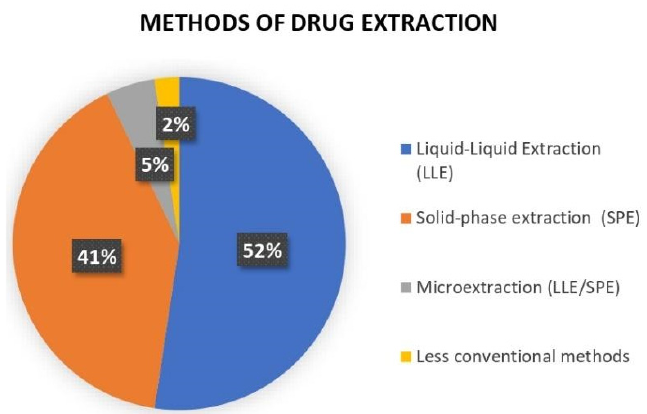
Figure 2. Synthesis of